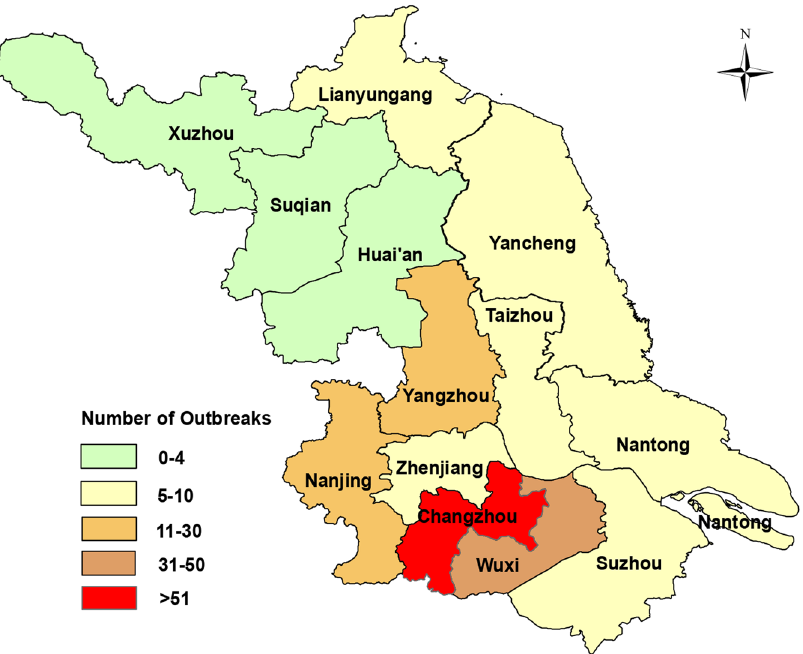
Figure 2. Spatial distribution of norovirus outbreaks in Jiangsu, China, 2015–2018. The outbreaks were shown by geographic locations. The number of the outbreaks was reflected with various colors.